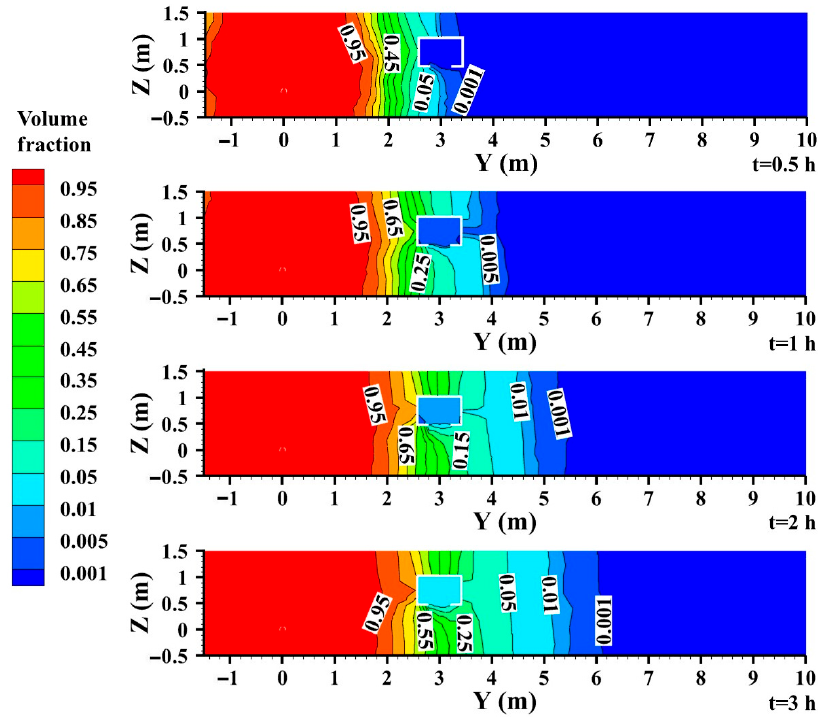
Figure 10. Cloud diagram of gas concentration distribution in confined space at different leakage times.